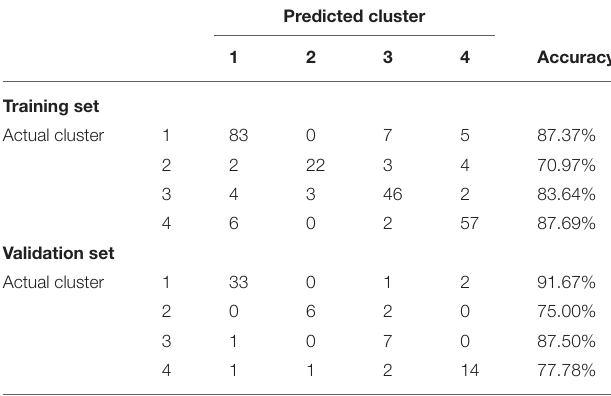
TABLE 5 | The random forest (classification)